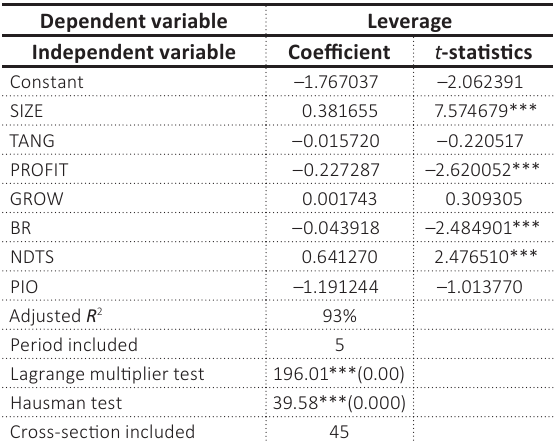
Table 4. The effect of service company characteristics on the capital